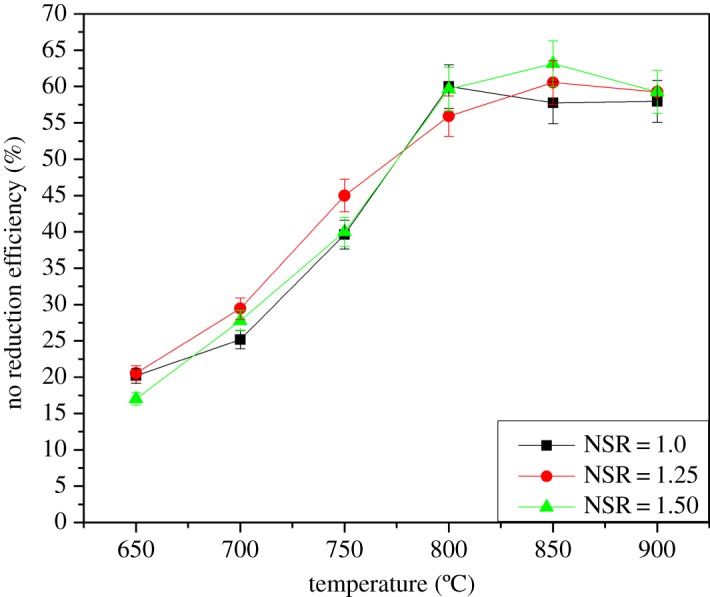
Effect of NSR on the urea-C2H5OH-based SNCR process.